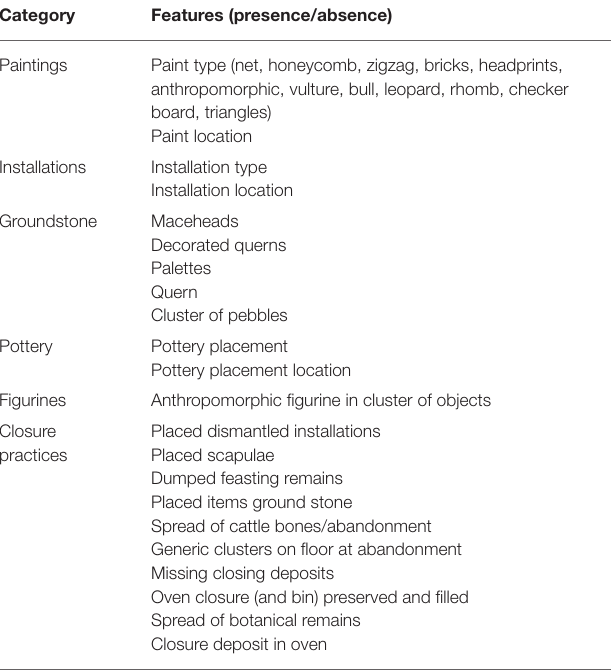
Anthropomorphic figurine in cluster of objects Closure